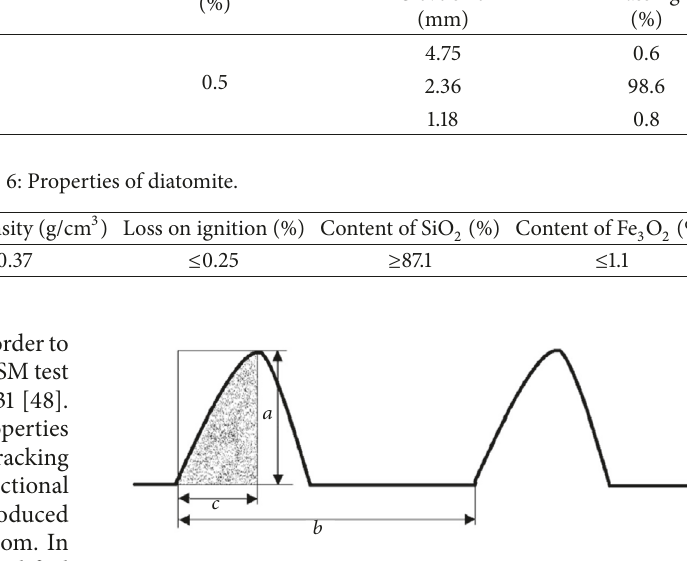
Figure 3: Load pulses in ITSM test: 𝑎 : peak load; 𝑏 : duration time; 𝑐 : rise